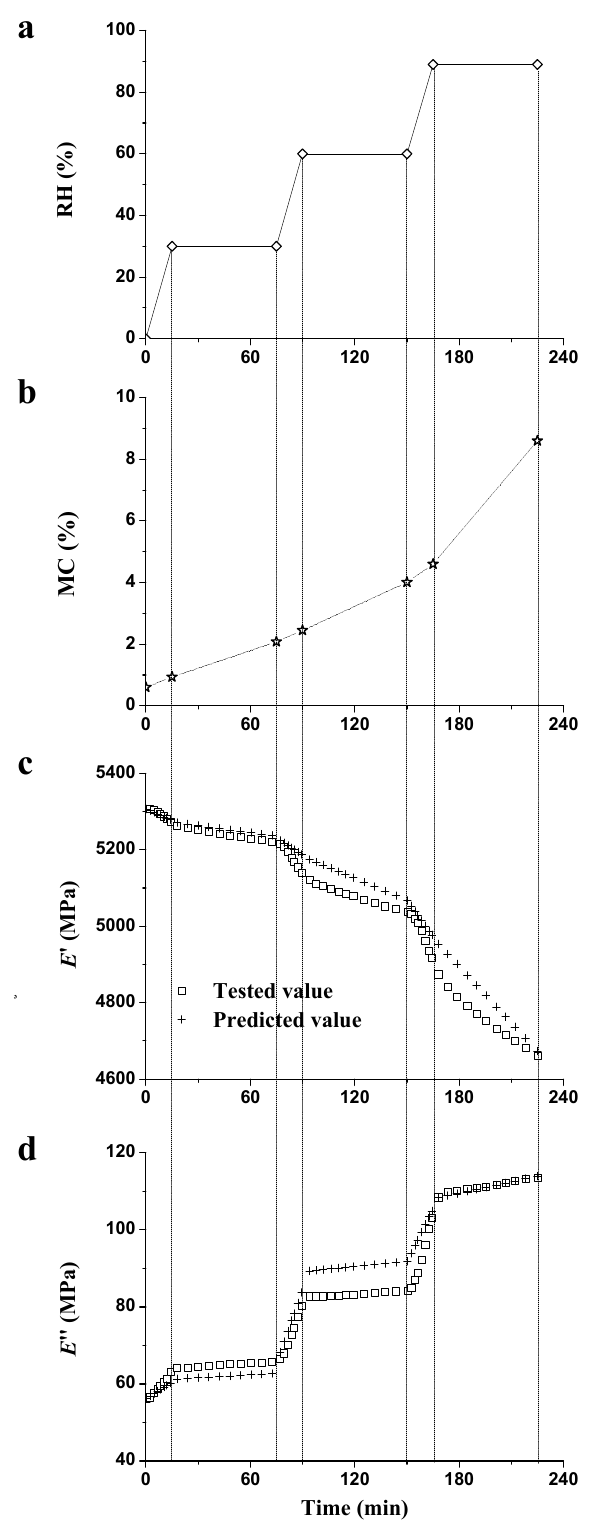
Figure 13. Changes of the RH ( a ); MC ( b ); normalized E ′ ( c ); and normalized E ′′ ( d ) during the RH step period (0% → 30% → 60% → 90% RH).